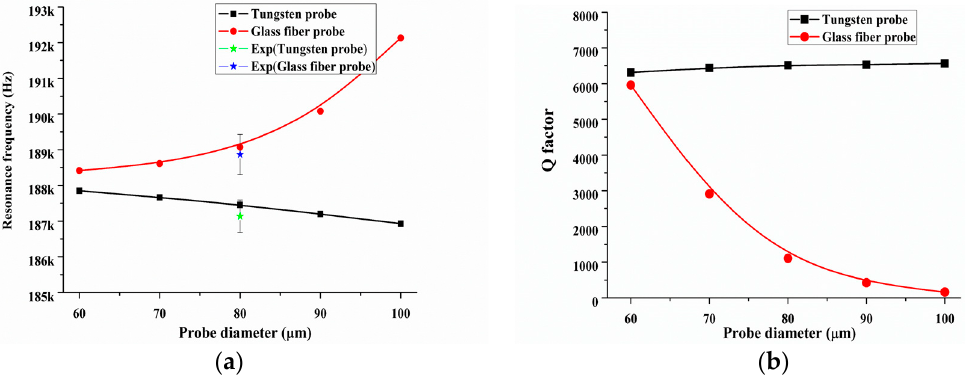
Figure 7. ( a ) Resonance frequency and ( b ) Q -factor changing with the increase of the probe diameter for tungsten and the glass fiber probes. The five-pointed star symbols denote experimental results.